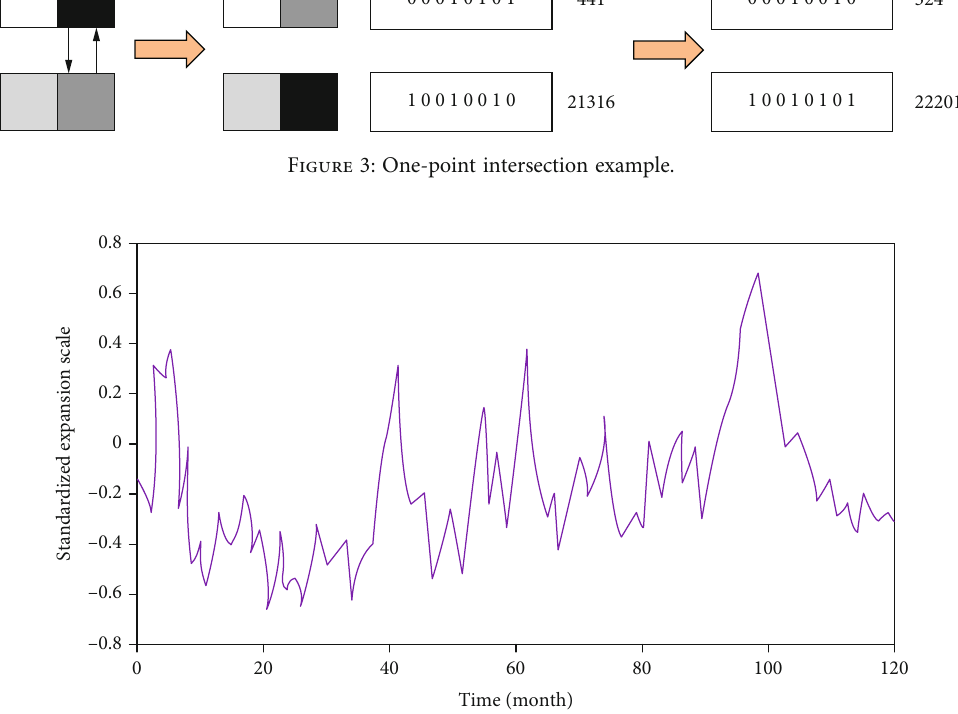
Figure 4: Normalized urban expansion curve. Table 1: Contribution rate of di ff erent